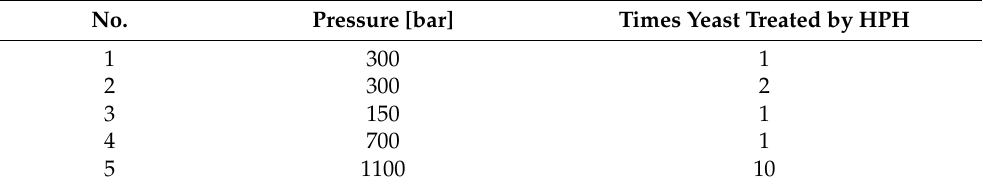
Table 3. Conditions for yeast treatment with high pressure